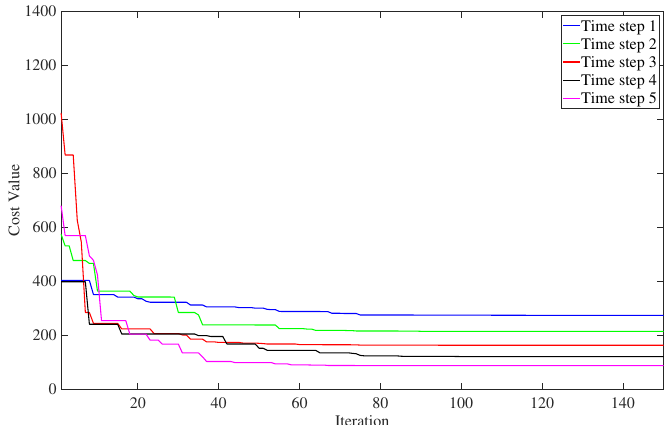
Figure 7. The cost values of the optimization process at five adjacent time steps.